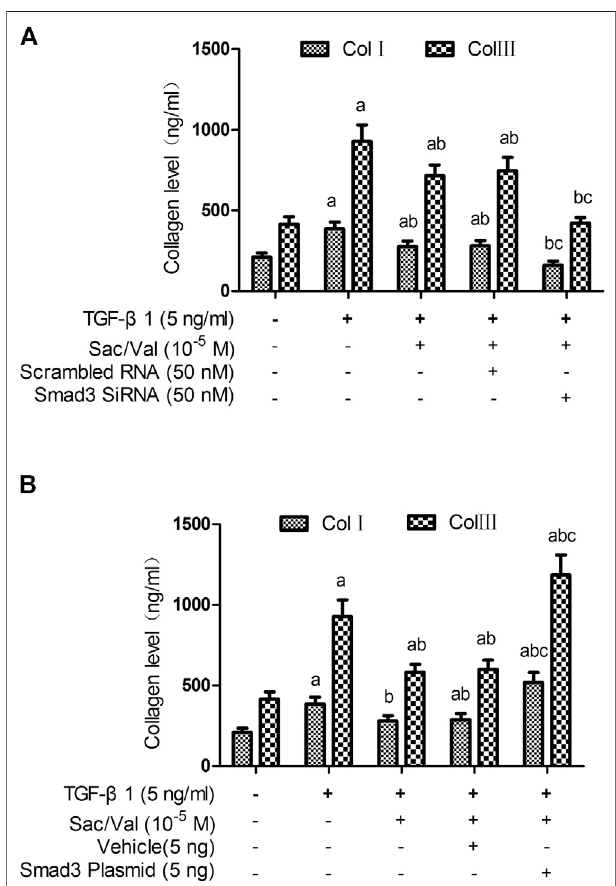
FIGURE 7 | Effect of Smad3 silencing and overexpression on the inhibitory effect of sacubitril/valsartan on TGF- β 1 -induced collagen synthesis by myocardial fi broblasts under hypoxia conditions. MFs were transfected with Smad3-speci fi c siRNA or a plasmid encoding for Smad3 to induce Smad3 silencing (A) and overexpression (B) , respectively, then the transfected cells were treated with sacubitril/valsartan (10 5 M) for 45 min, followedwithTGF- β 1(5 ng/ml)co-incubationinhypoxiaenvironmentfor48 h. The supernatant was collected and collagen levels were measured by ELISA. Col Ⅰ , type Ⅰ collagen; Col Ⅲ , type Ⅲ collagen; TGF- β 1, transforming growth factor- β 1; Sac/Val, sacubitril/valsartan. Results are mean ± SD ( n (cid:1)